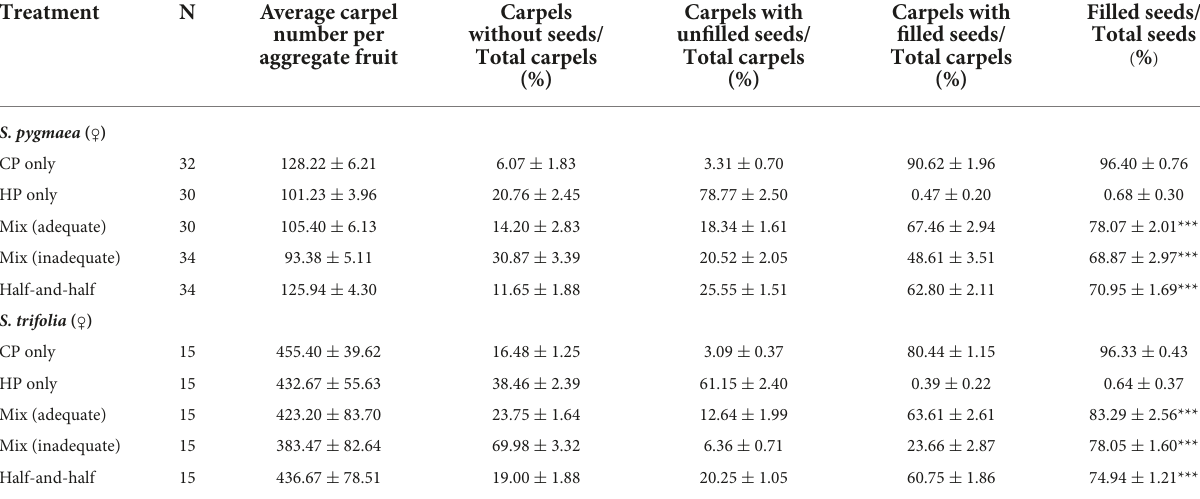
TABLE 2 Percentages of each mature seed phenotype resulting from different hand-pollination treatments in Sagittaria pygmaea and S. trifolia. Treatment N Average carpel